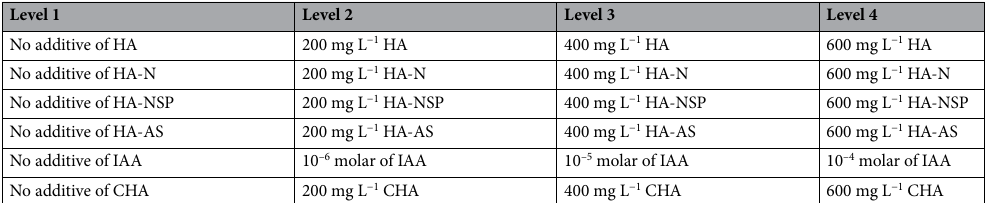
Table 3. Application level [1—HA extracted from VC without enrichment (HA); 2—HA extracted from VC enriched with 1% nitrogen (HA-N); 3—HA extracted from VC enriched with 1% nitrogen, 1% sulfur, and 1% phosphorus (HA-NSP); 4—HA extracted from VC enriched with Azotobacter chroococcum (21Az) + Pseudomonas fluorescens (Ps 59) (HA-AS); 5—Commercial humic acid (CHA); 6—Indole-3-acetic acid